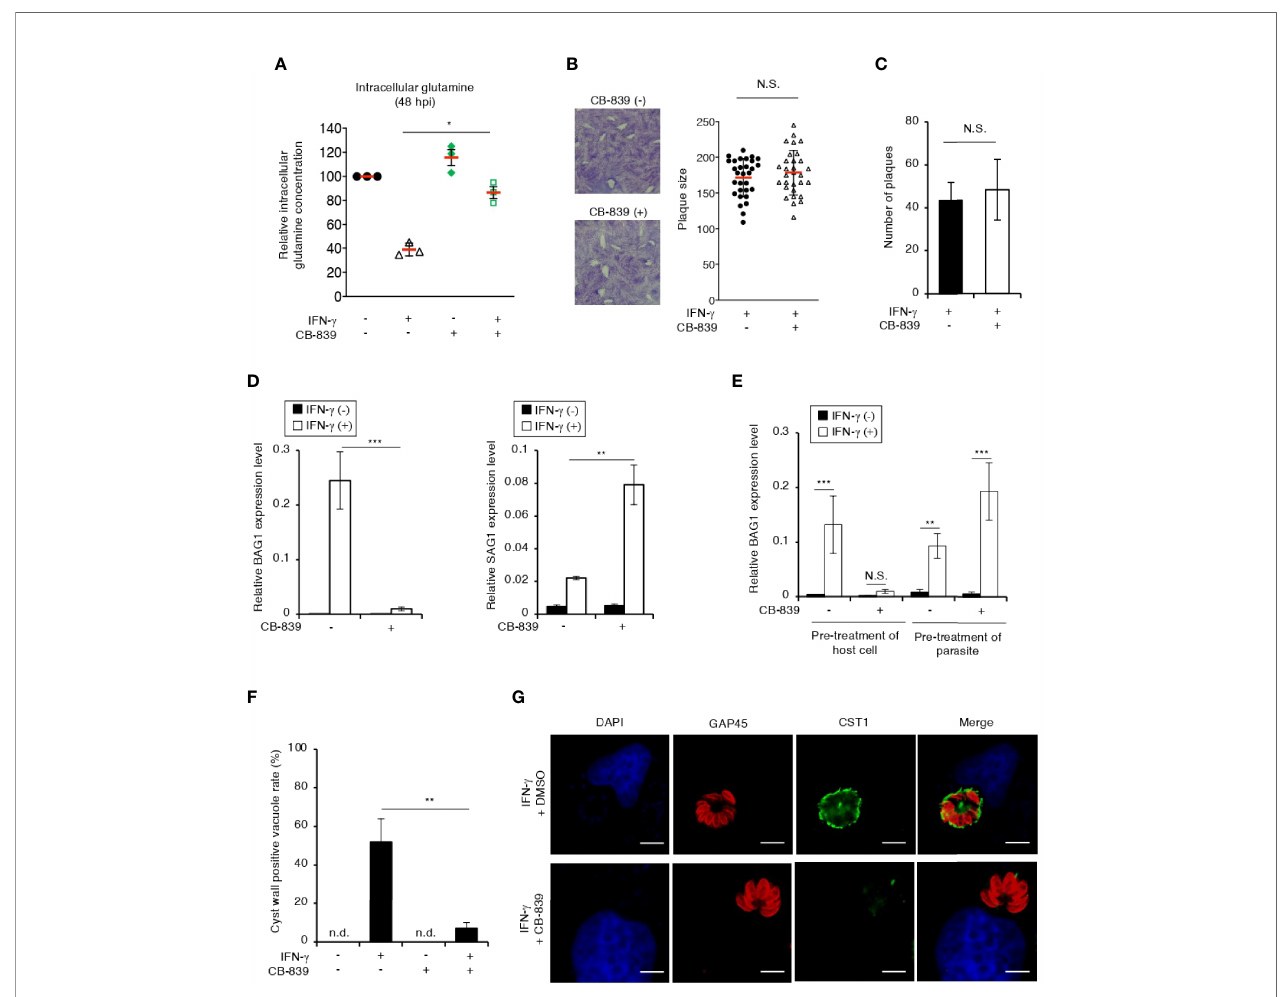
FIGURE 5 | IFN- g -dependent T. gondii stage conversion is suppressed by treatment with a glutaminase inhibitor in human neuroblastoma cells. (A) IMR-32 cells infected with T. gondii ME49 were untreated or treated with IFN- g and/or CB-839. The level of intracellular glutamine at 48 h after parasite infection was measured by ELISA. (B, C) HFF cells infected with T. gondii ME49 were treated with IFN- g and/or CB-839. Plaques were stained at 4 days post-infection. (B) Plaque sizes were measured by using the Image J software. (C) Plaque numbers of individual strains were counted. (D) IMR-32 cells infected with T. gondii ME49 were untreated or treated with IFN- g and/or CB-839 and incubated for 0 or 48 h. The BAG1 or SAG1 mRNA level at 48 h after parasite infection was analyzed by use of quantitative RT-PCR. (E) IMR-32 cells or T. gondii ME49 were pretreated with CB-839 for 3 h, and then washed before infection. CB-839-pretreated or untreated IMR-32 cells were infected with pre-treated or untreated T. gondii ME49. The BAG1 mRNA levels at 48 h after parasite infection were analyzed by use of quantitative RT-PCR. (F, G) IMR-32 cells infected with T. gondii ME49 were treated with IFN- g and/or CB-839. Cyst wall formation was assessed by IFA at 72 h post-infection. (F) The percentage of CST1-positive vacuoles was determined. (G) Representative IFA images of T. gondii GAP45 (red) and CST1 (green); nuclei were stained with DAPI (blue). Scale bars correspond to 5 m m. Data are representative of three independent experiments. Values are means ± SD (three biological replicates per group from three independent experiments) (A – F) . * p < 0.01, ** p < 0.01, *** p < 0.001; N.S., not signi fi cant; n.d., not detected; Student ’ s t